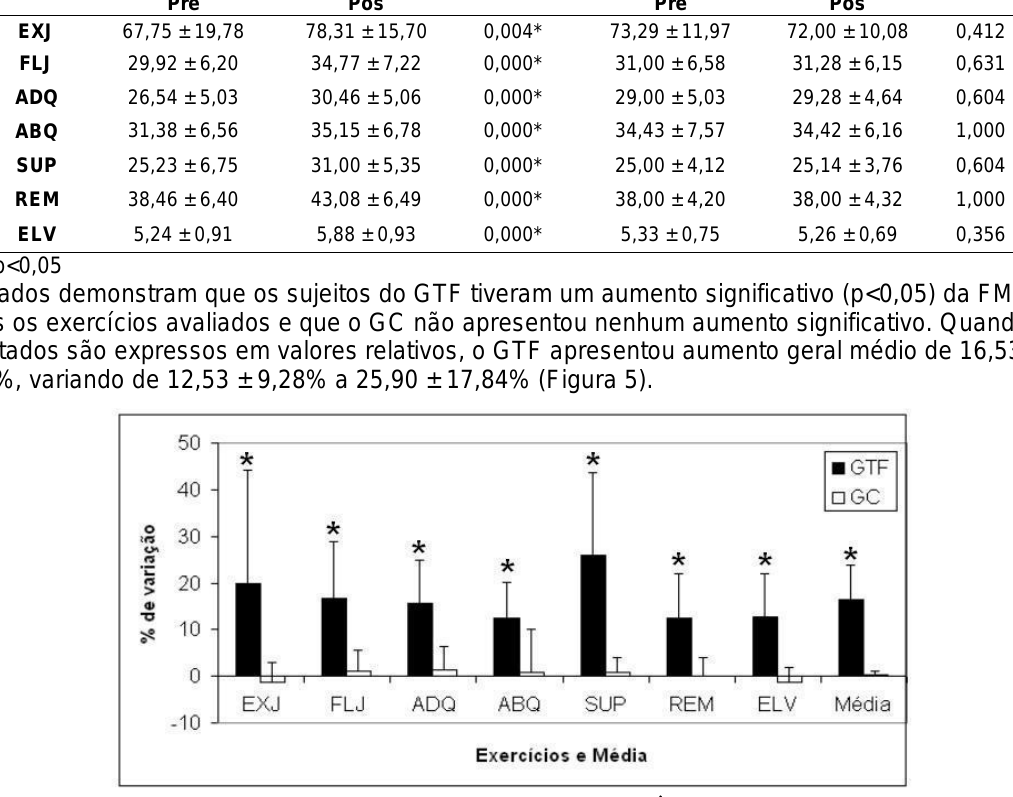
Figura 5. Gráfico dos valores relativos de aumento de força (  %) dos sete exercícios analisados e a média deles, no grupo treinamento de força (GTF) e grupo controle (GC). As colunas com * representam as diferenças significativas (p<0,05) do aumento de força entre os pré e pós-testes dos exercícios no